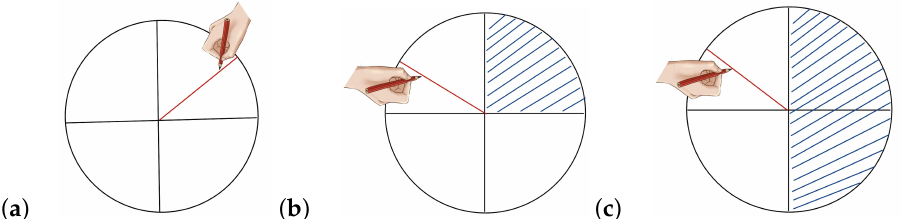
Figure 1. The scheme of the triple quasi-experiment on a continuum of equivalent alternatives. ( a ) Experiment 1: subjects were allowed to draw lines in any direction. ( b ) Experiment 2: subjects could draw lines at any angle, excepting those in the first quadrant. ( c ) Experiment 3: the first and second quadrants were barred, but subjects could draw lines at any angle within the left side of